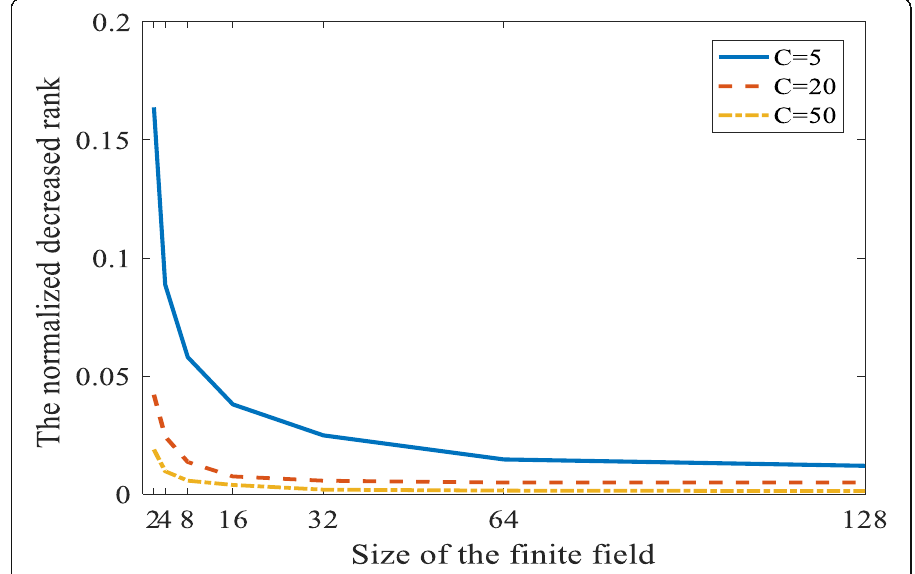
independent with the first selected row is 1 − | F | − ( C − 1) . The rest rows can also be con- q ∣ = 2 and C approximate infinity, sidered in a similar way. Consider the case that ∣ F q the probability that T is a full rank is about 0.289 based on [9]. The probability rank of T that declines no more than 2 is (1 − 2 − C ) × (1 − 2 − ( C − 1) ) × ⋯ (1 ‐ 2 − 3 ), where (1 ‐ 2 − 2 ) × (1 ‐ 2 − 1 ) is not included. If C approximates infinity, (1 − 2 − C ) × (1 − 2 − ( C − 1) ) ×